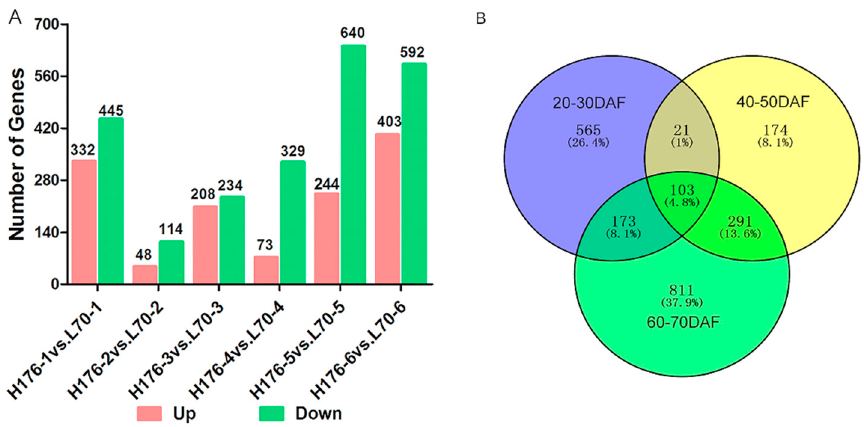
Figure 2. Statistical analysis of all identified differentially expressed genes (DEGs) in L70 and H176. ( A ) Statistical analysis of differentially expressed genes (DEGs) at different seed development stages in H176 vs. L70. ( B ) Venn diagram showing the distribution of DEGs at three periods of seed development in H176 vs. L70. The blue circle indicates the 20–30 DAF, the yellow circle indicates the 40–50 DAF, and the green circle indicates 60–70 DAF.